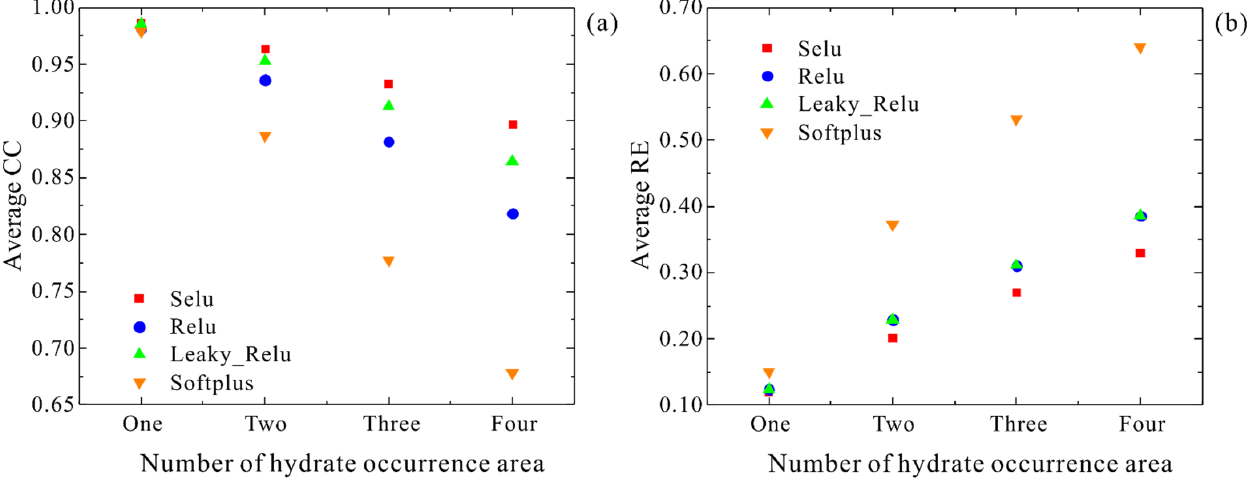
Figure 10. The average RE and CC of different samples in the test set for different activation functions. ( a ) average CC, ( b ) average RE.